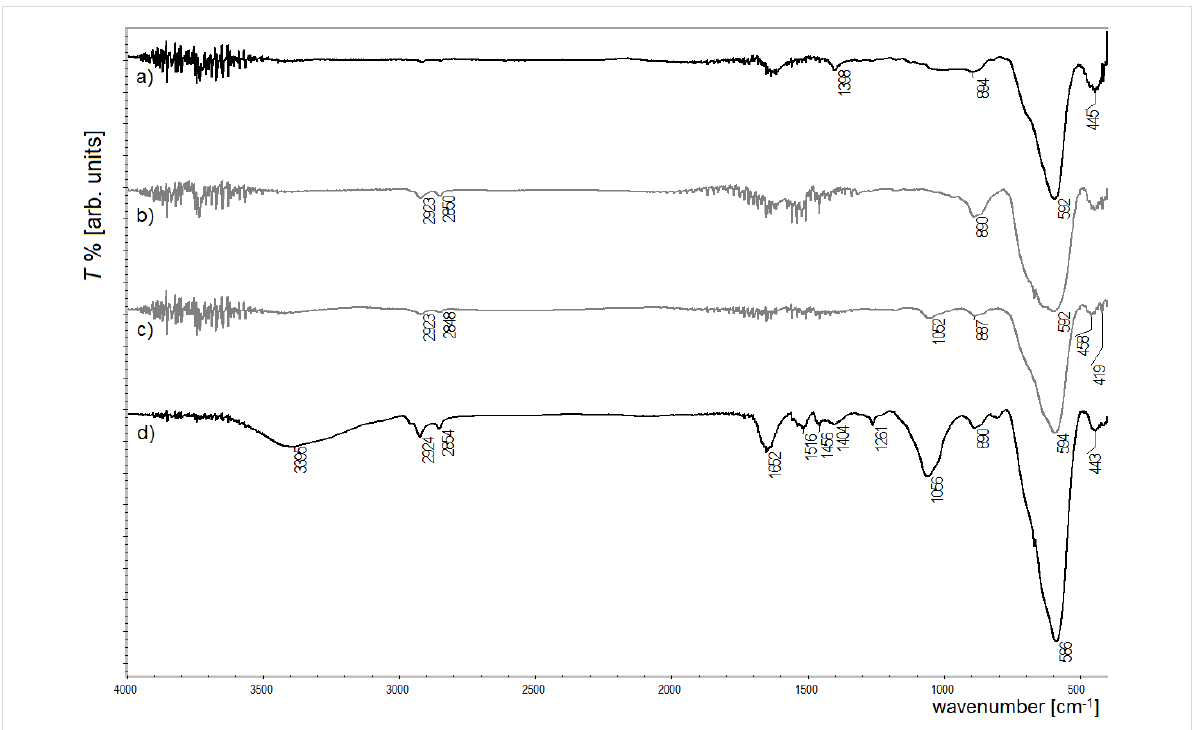
Figure 5: IR spectra of a) Fe 3 O 4 ; b) Fe 3 O 4 after surface phase change; c) Fe 3 O 4 after modification with glutaraldehyde; d) Fe 3 O 4 after attachment of